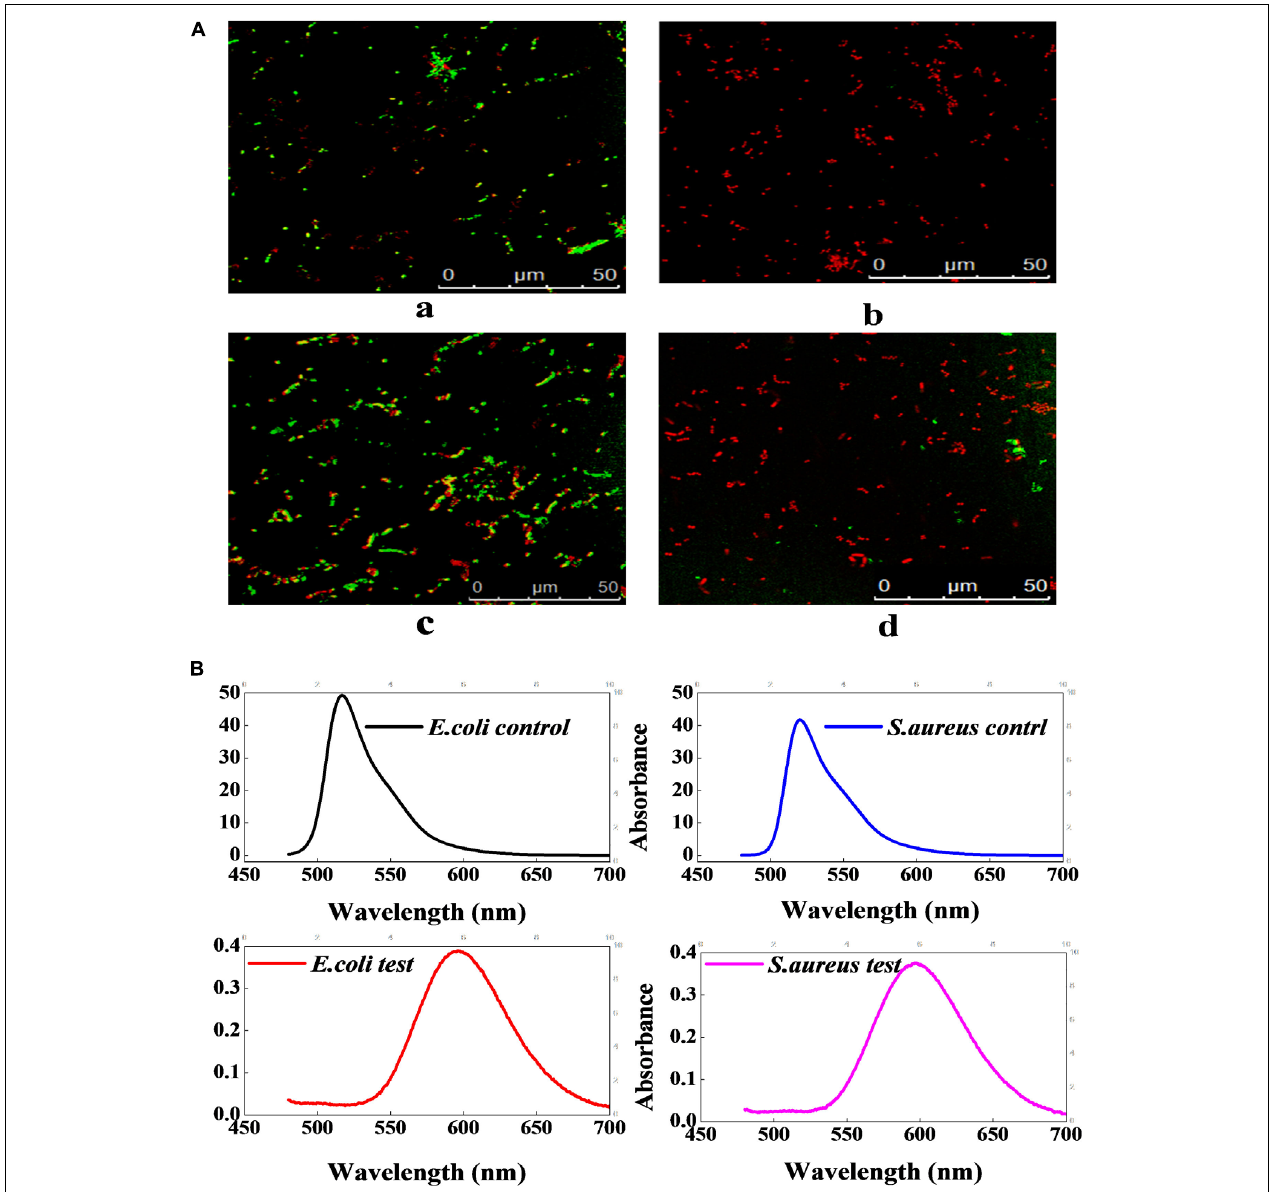
FIGURE 5 | The effect of lacidophilin on the cell membrane integrity of the two indicator bacteria. Fluorescence micrograph of E. coli and S. aureus with FDA/PI staining (A) ; the S. aureus used as control (a) , the treated S. aureus (b) , the E. coli used as control (c) , the treated E. coli (d) . Fluorescence spectrum of E. coli and S. aureus with FDA/PI staining (B) ; the excitation wavelength was 450